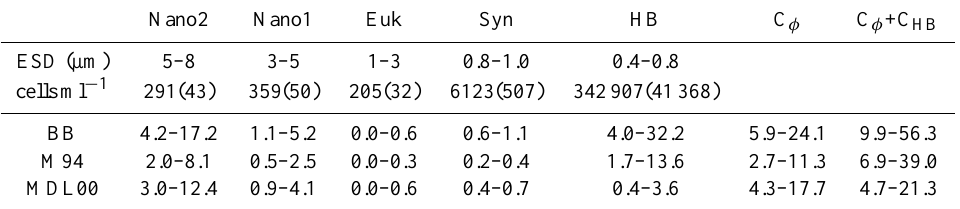
Table 5. Phytoplankton and heterotrophic bacterial carbon (mgm − 3 ) estimated from flow cytometric cell abundances, equivalent spherical diameters (ESD) and published carbon densities. C φ is the total phytoplankton carbon, C HB is the carbon of heterotrophic bacteria. Different values of carbon density were used: in BB the value for eukaryotes was 0.22pgCµm − 3 (Booth, 1988) while that for Synechococcus and heterotrophic bacteria (HB) was 0.35pgCµm − 3 (Bjornsen, 1986); in M94 and MDL00 algal carbon densities were taken from the relation- ships published by Montagnes et al. (1994) and Menden-Deuer and Lessard (2000), respectively. HB carbon density was 0.148pgCµm − 3 (exponentially growing organisms, Vrede et al., 2002) in M94 and 0.039pgCµm − 3 in MDL00 (phosphorous limited, Vrede et al.,